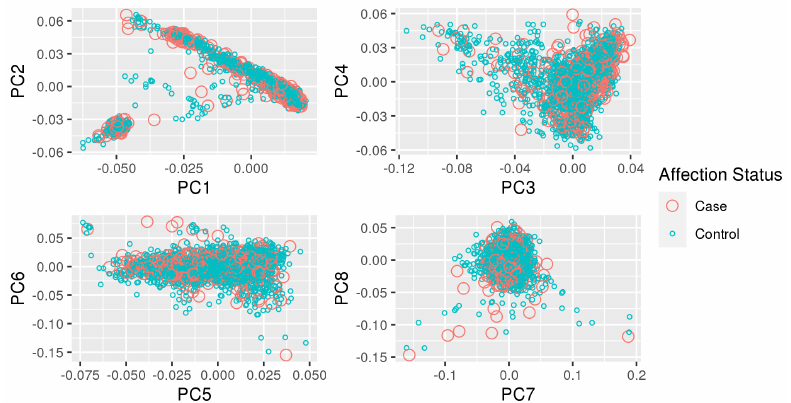
Figure A1. First eight principal components of the HRC-imputed genotype data downloaded from Partners Biobank. Stratification by genomic chip.